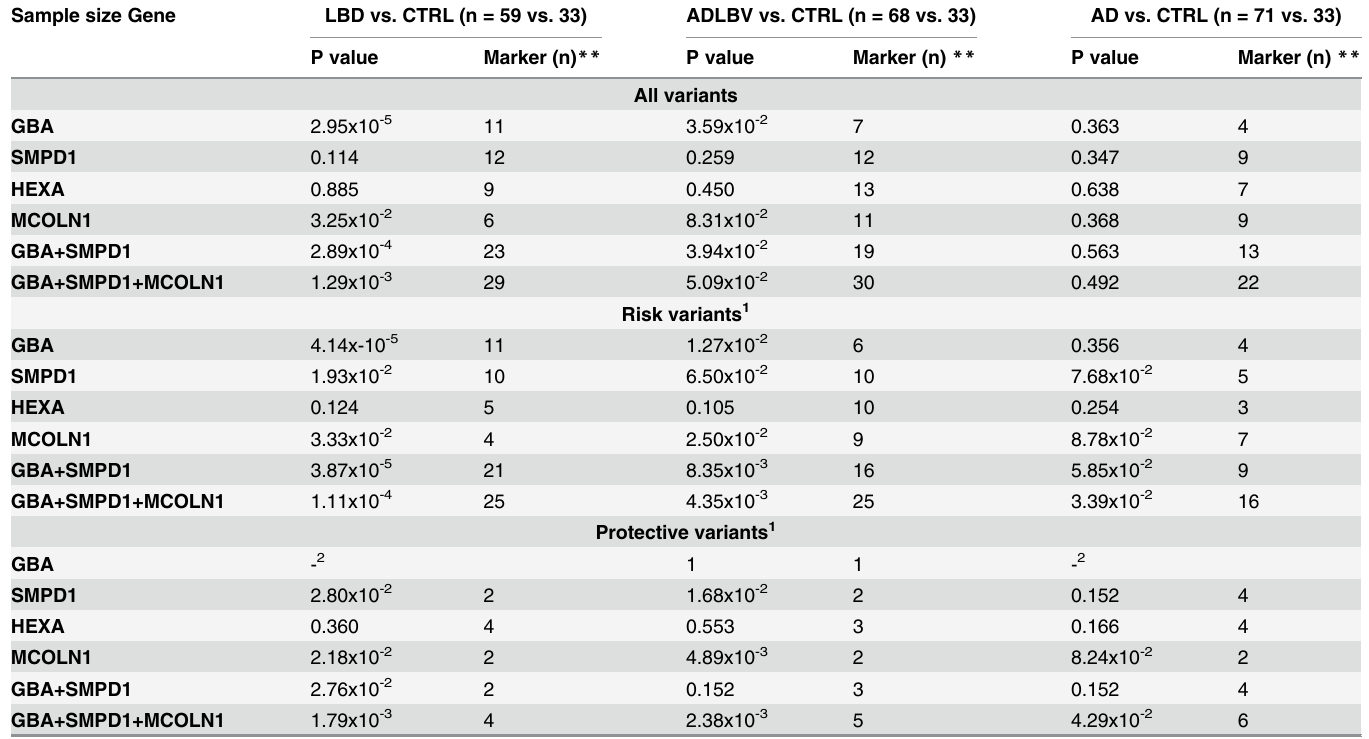
Table 3. Gene wise association SKAT analysis * in all samples. Sample size